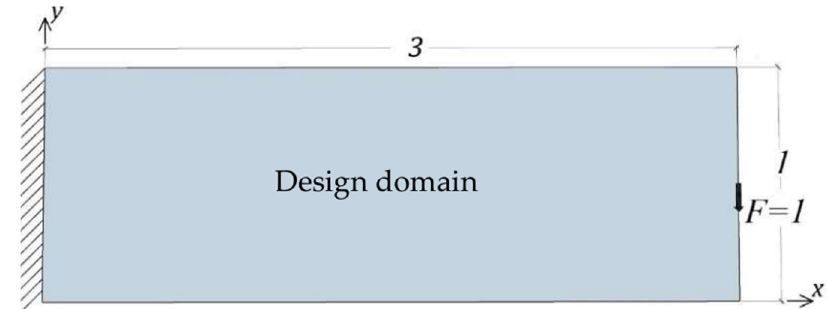
Figure 5. Problem definition of the cantilever plate (case 3): design domain, loading, and supports.